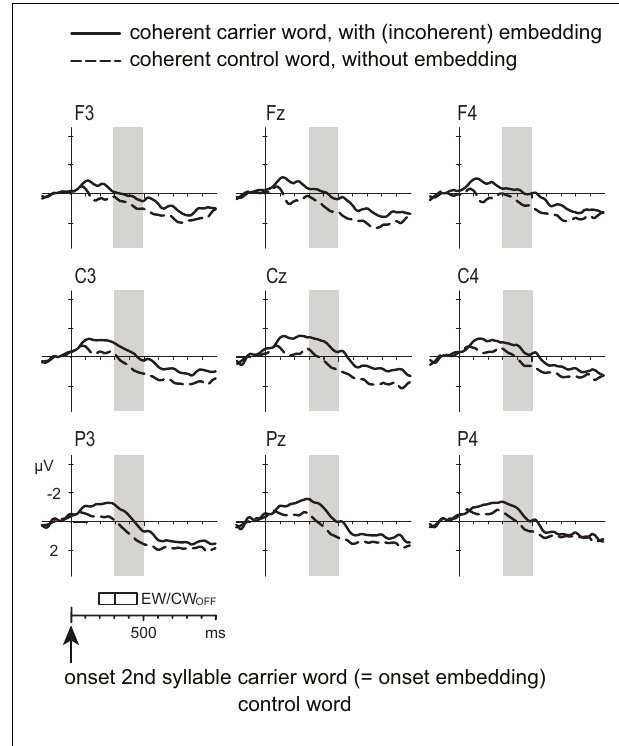
FIGURE 3 | Grand average event-related potentials from nine scalp sites to coherent carrier words with final embeddings (solid line), and to coherent control words without embeddings (dashed line), after baseline correction in the 200-ms prestimulus interval, time-locked to the onset of the second syllable of the carrier/control words, which corresponds to the onset of the final embeddings. The bars in the lower left corner indicate the offset of the embedded words (EW OFF ), and the offset of the carrier words (CW OFF